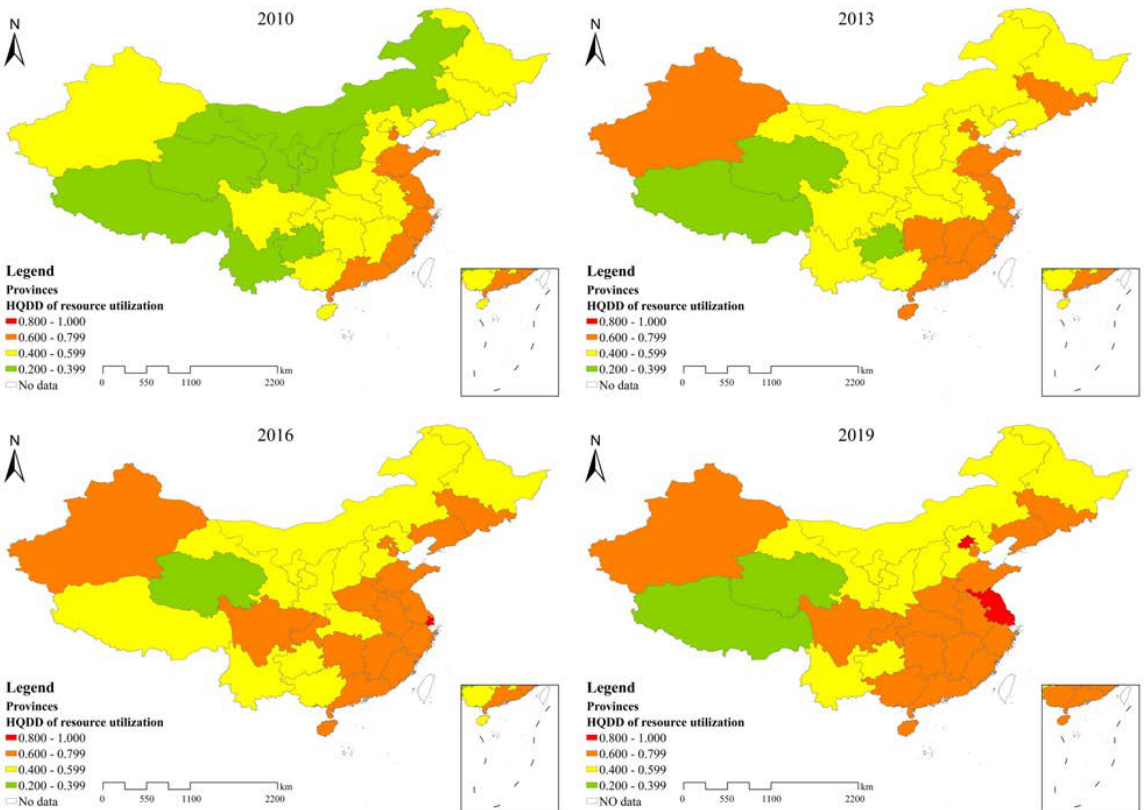
Figure 4. Spatial distribution of HQDD of the resource utilization system in 31 PLARs in 2010, 2013, 2016, and 2019.